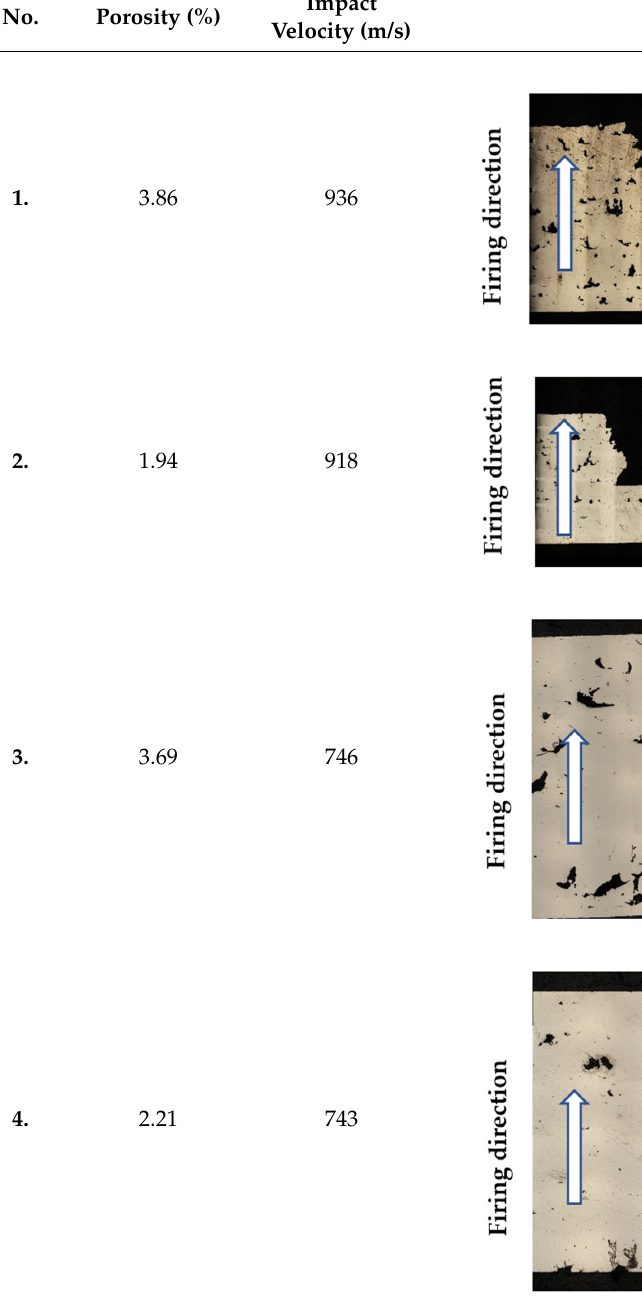
Table 4. Material structure before (BHT), after (AHT) heat treatment, and after deterioration with different velocities. No. Porosity (%)